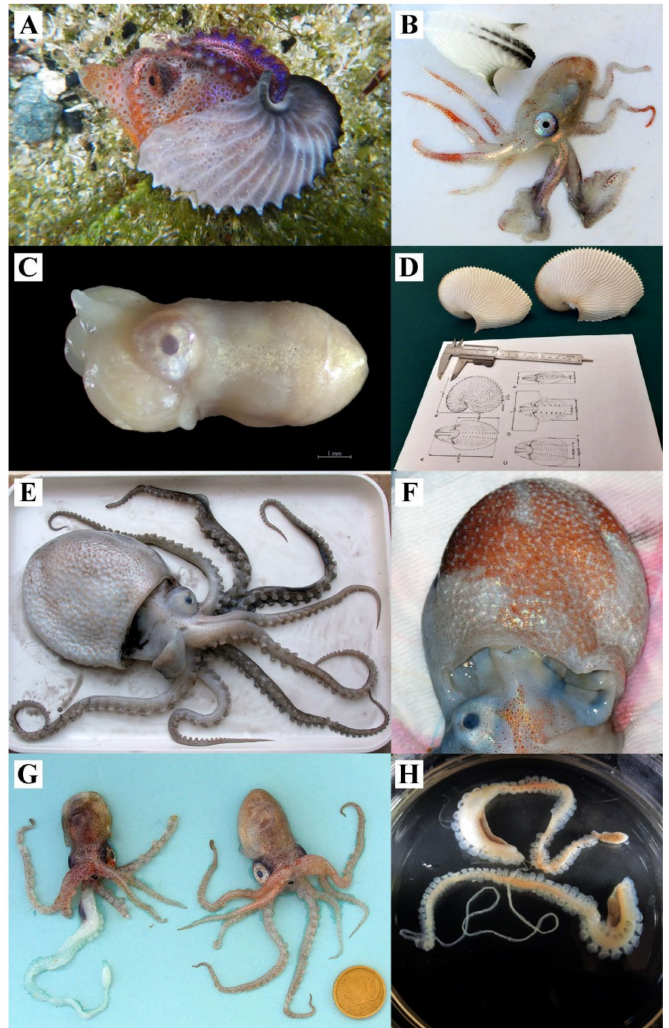
Figure 2. ( A ) Lateral view of a live female of Argonauta argo photographed in the Strait of Messina; ( B ) Female specimen of A. argo stranded in the Strait of Messina, this figure shows the first pair of dorsal arms used to secrete the ootheca; ( C ) A mature male of A. argo showing its hectocotylized arm enwrapped in a sac under the left eye; ( D ) Data collection (measurements) from A. argo oothecae in the laboratory; ( E ) Ocythoe tuberculata female caught by a recreational fisherman in 2018 (Southern Tyrrhenian Sea); ( F ) Details of the ventral mantle of O. tuberculata , showing skin ridges and tubercles; ( G ) Two specimens of O. tuberculata found in 2008 in the Strait of Messina. Mature male with hectocotylus (left) and young female (right); ( H ) two hectocotyli found in the mantle cavity of a female O. tuberculata